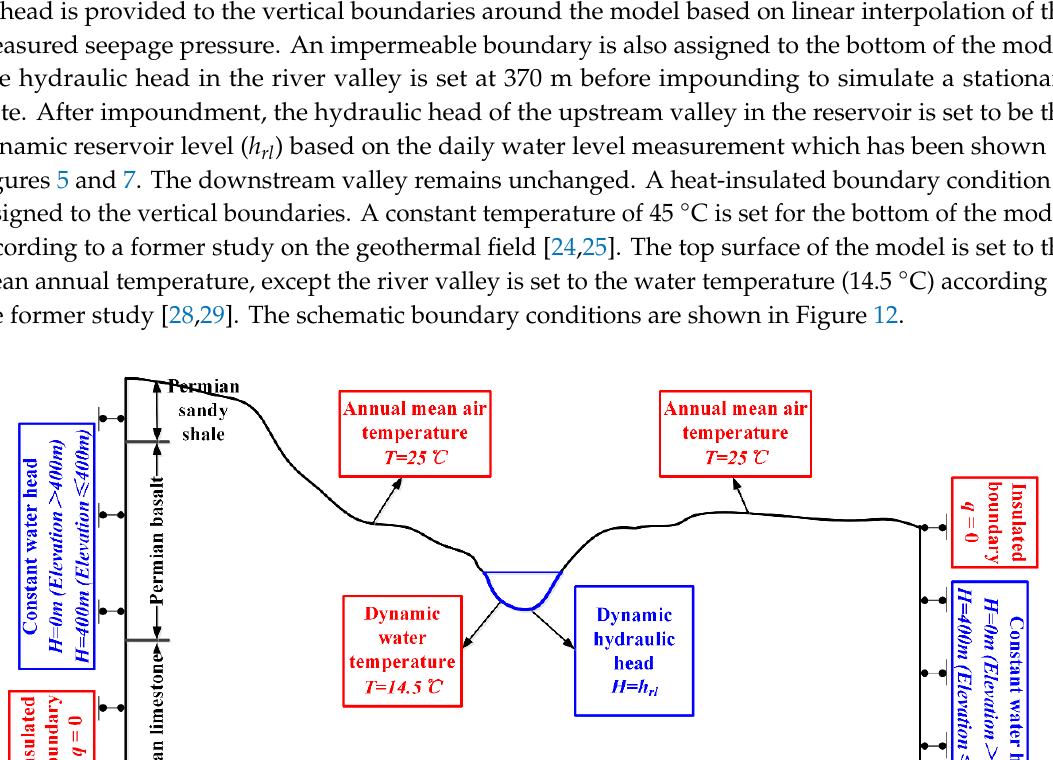
Table 3. Material parameters of the finite element method (FEM) model.